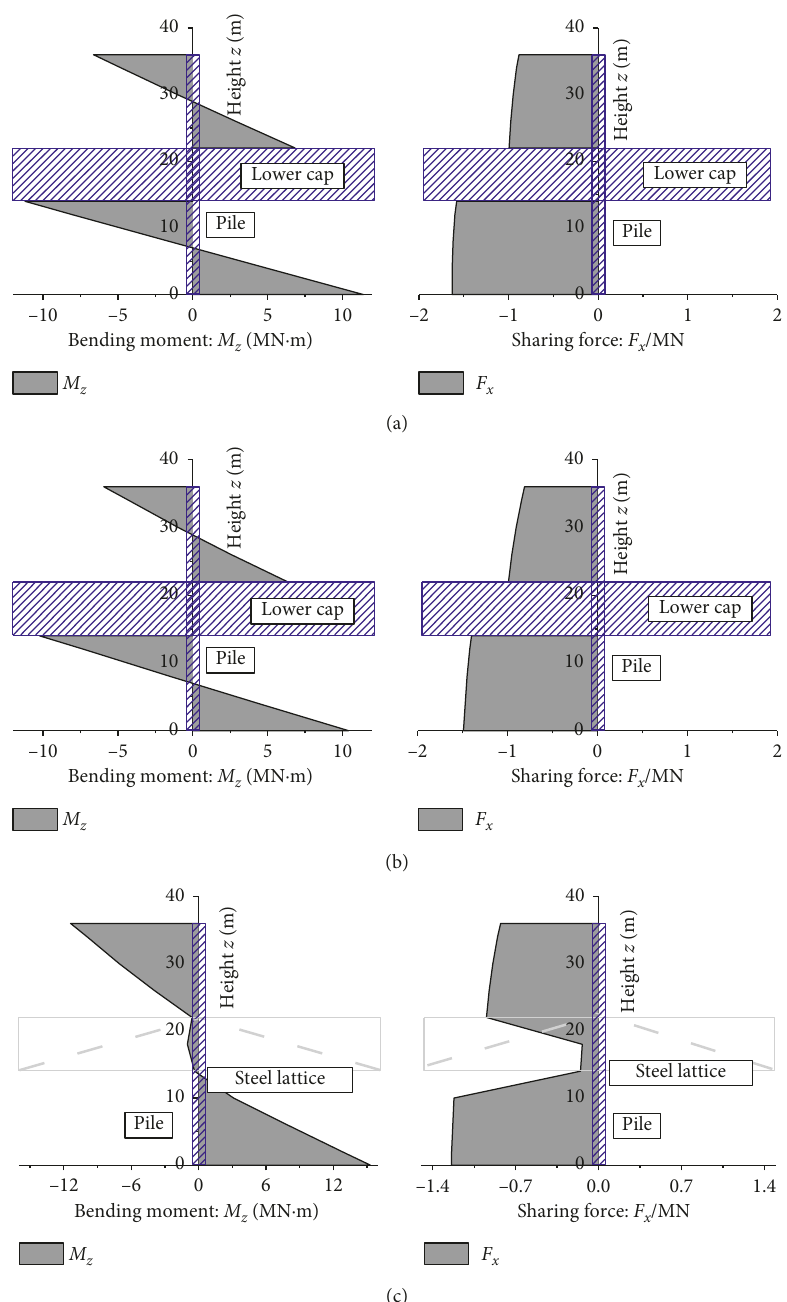
Figure 14: Comparison of internal forces on different foundations. (a) Double caps foundation. (b) Three caps foundation. (c) Joint piles